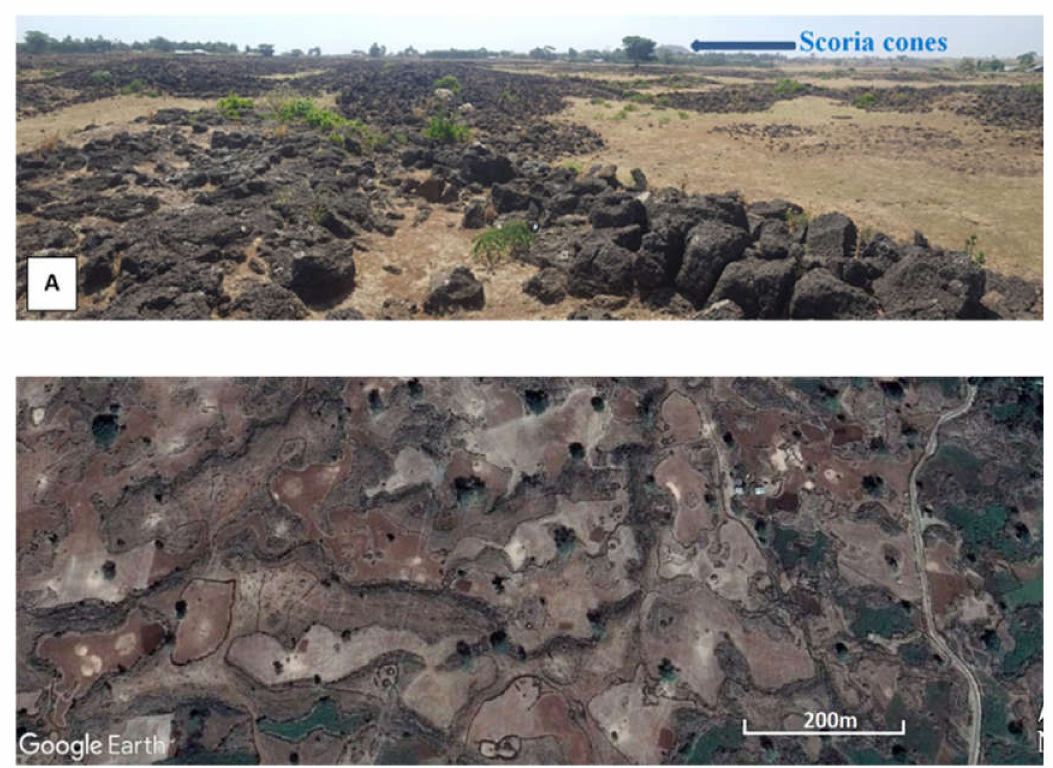
Figure 4. Young Quaternary volcanic rock unit forming a gently undulating plain which creates depressions surrounded by blocky fractured rocks; ( A ) field photo and ( B ) Google Earth image (February 13, 2018). 37P: 311954.76, 1281626.29 N, eye alt, 3.31 km, Image © 2019 CNES / Airbus. https: // www.google.com / maps / @11.58995,37.279,7096m / data =